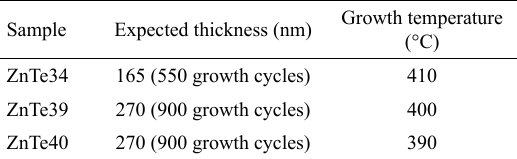
Table 1: ZnTe growth conditions used for samples presented in Figure 6 grown on GaSb